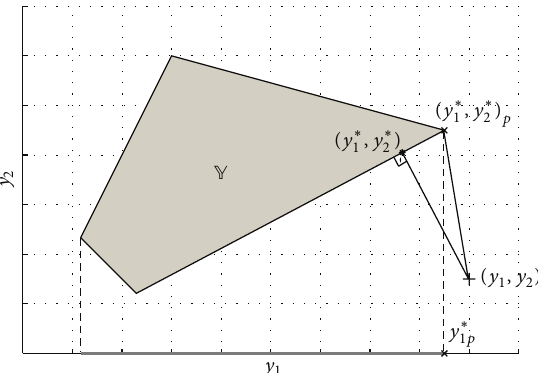
Figure 1: Orthogonal and prioritized projections of a point on a